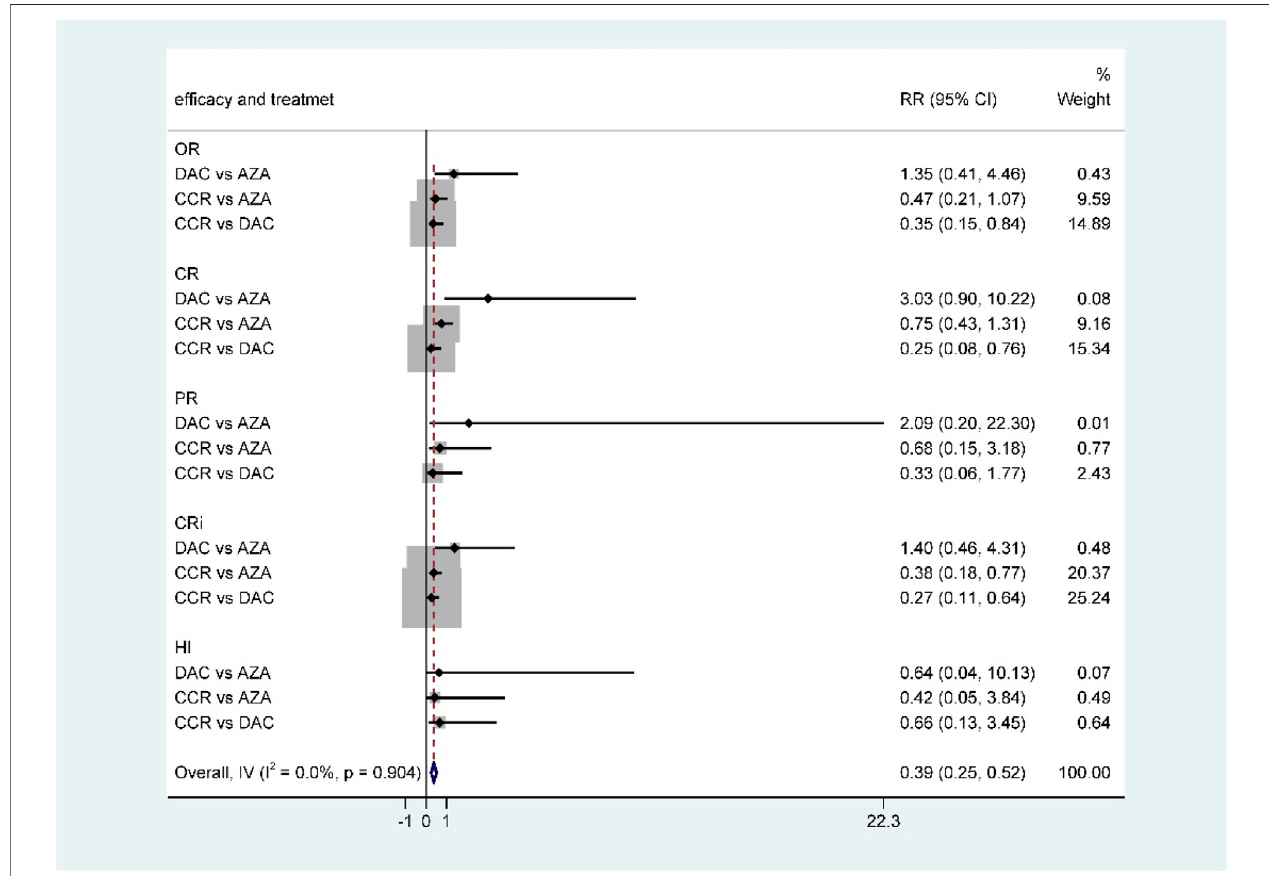
FIGURE 6 | Forest plot of ef fi cacy represents the direct and indirect comparison.